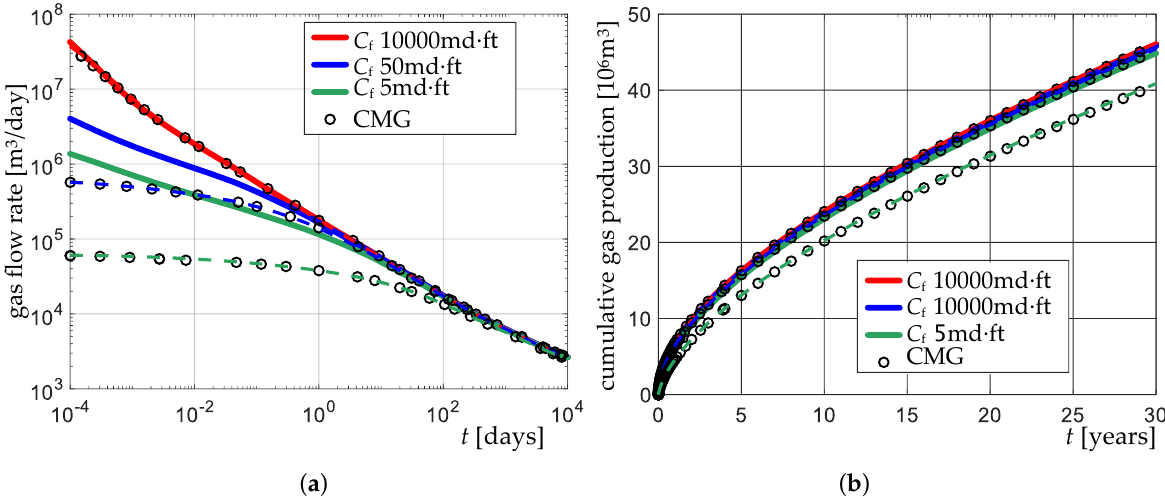
Figure 11. Results of the VE1A simulation: ( a ) gas flow rate and ( b ) cumulative gas production versus time t for fracture conductivity C f equal to 5 (green lines), 50 (blue lines) and 10,000 (red lines) mD-ft. Solid lines— ShOpen /EDFM; dashed lines— ShOpen /EFM;